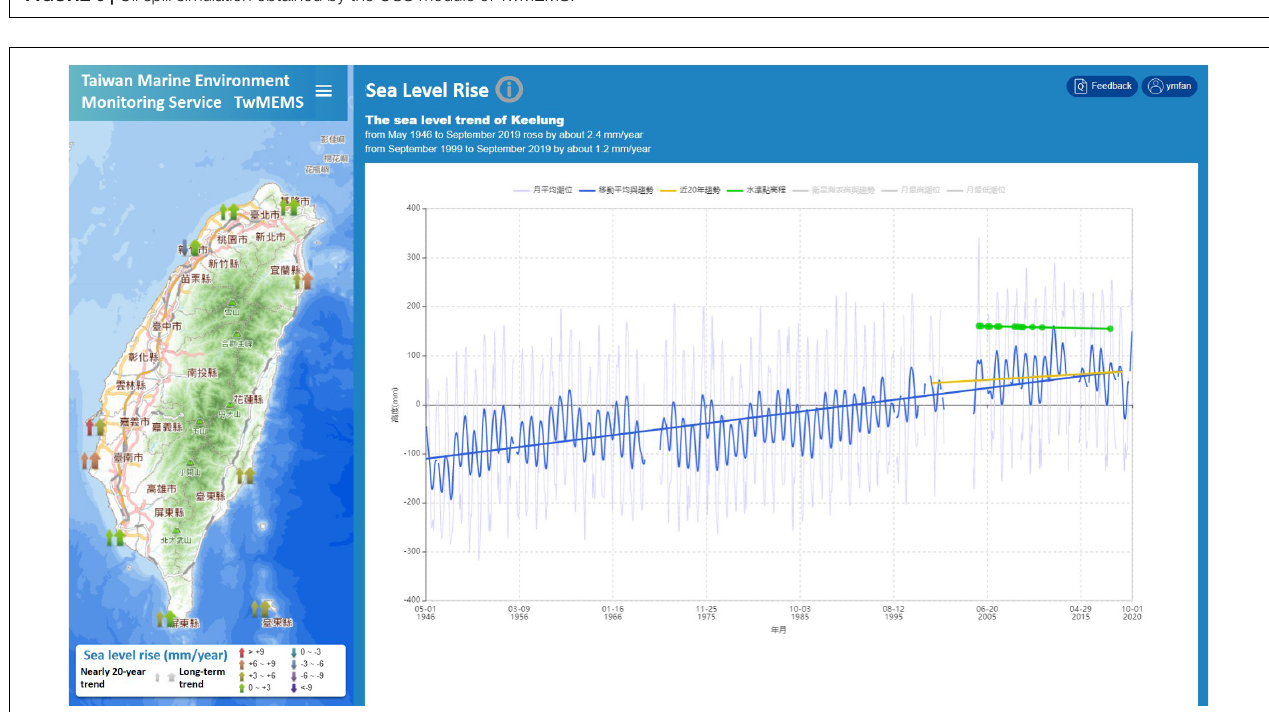
FIGURE 6 | Oil spill simulation obtained by the OSS module of TwMEMS.